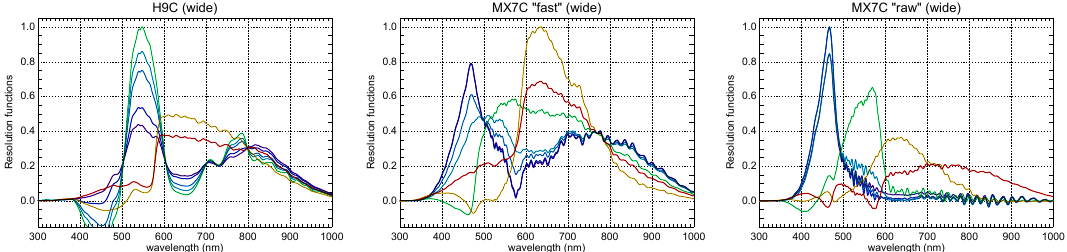
Figure 14. Resolution/window functions ( A ) without an infrared-blocking hot mirror.